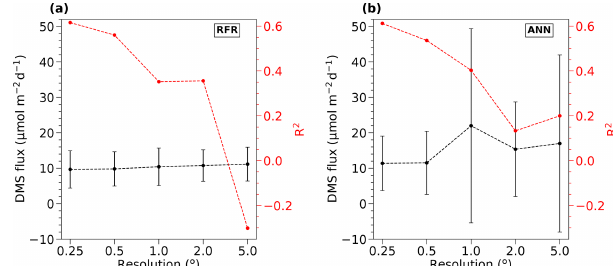
Figure 1. Sensitivity of RFR and ANN models to grid size reso- lution. DMS fluxes (black) and R 2 values (red) derived from sen- sitivity tests of (a) RFR and (b) ANN models to pixel resolutions of 0.25–5 ◦ . The negative R 2 values observed at the lowest resolu- tion (largest grid cells) indicate that the predicted values explain less variance than the overall mean of the dataset.